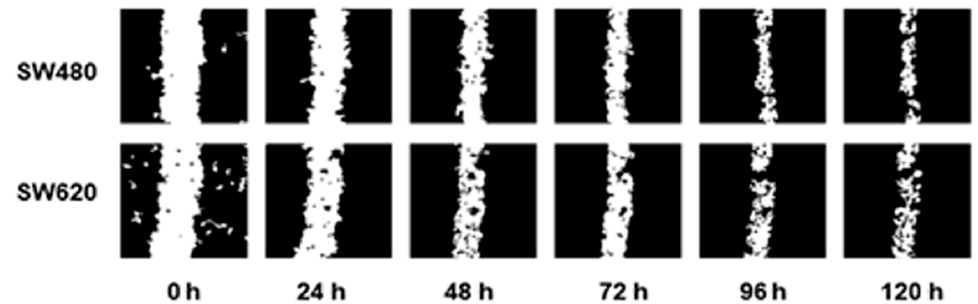
Figure 5. Migration pattern of the colorectal cancer cell lines SW480 and SW620 without treatments and without SBF supplementation. Images were captured in intervals of 24 h during 120 h.